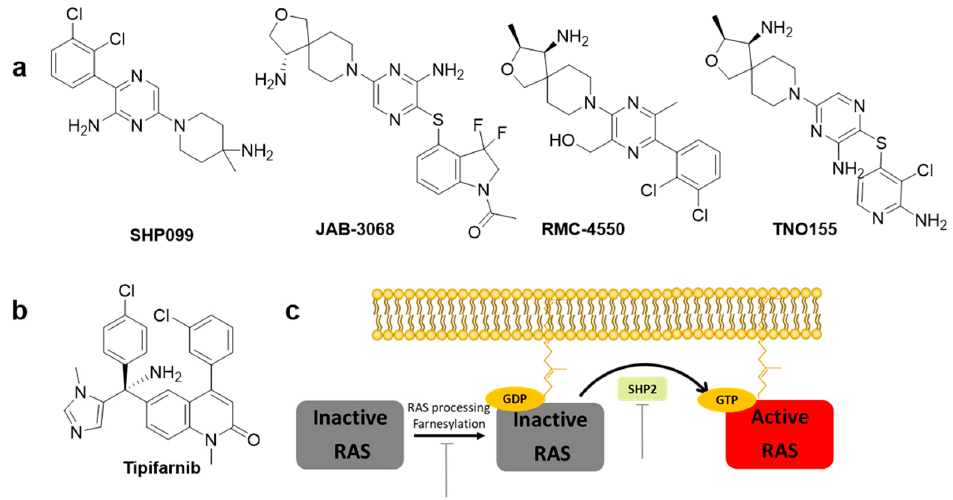
Figure 4. Chemical structures of indirect inhibitors of KRAS. ( a ) SHP2 inhibitors. ( b ) RAS processing inhibitor. ( c ) RAS processing, RAS activation, and target inhibition sites.